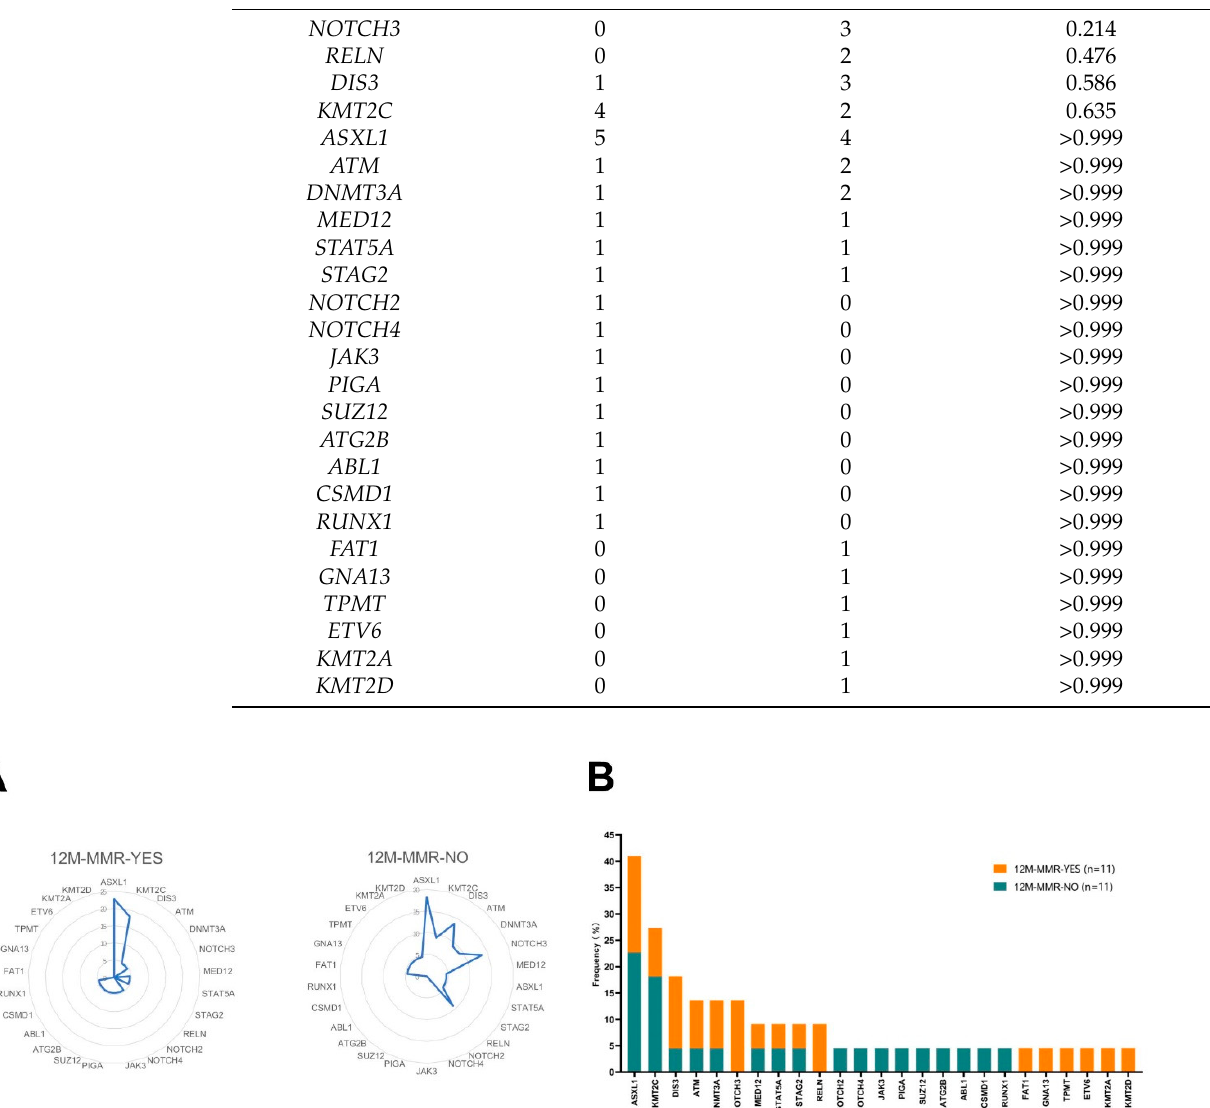
Table 3. Mutation analysis in the 36M-MR 4.0 group and non 36M-MR 4.0 group. Gene